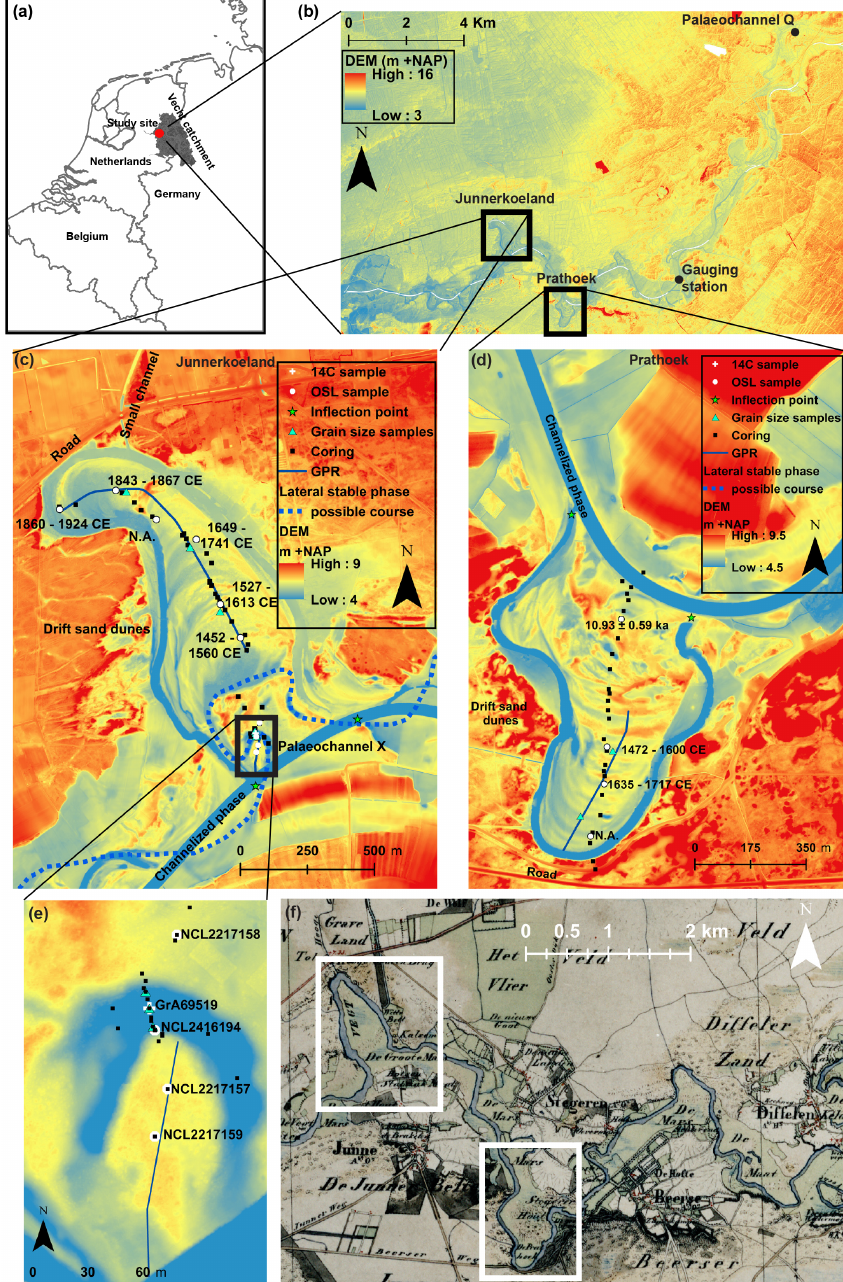
Figure 1. Maps of the Overijsselse Vecht. (a) Map showing the location of the Overijsselse Vecht catchment and the location of the study site. (b) Digital elevation map (DEM; Actueel Hoogtebestand Nederland, 0 . 5 × 0 . 5m) (Van Heerd and Van’t Zand, 1999) of the downstream section of the Overijsselse Vecht river, indicating both study sites: Junnerkoeland and Prathoek. DEM of the Junnerkoeland bend (c) and Prathoek bend (d) , including locations of cores, OSL samples by Quik and Wallinga (2018), the OSL and 14 C samples from this study, the GPR transects, the grain size samples, and inflection points. The possible historical course of Palaeochannel X according to Maas (1995) is indicated. (e) Zoomed-in figure of Palaeochannel X . (f) Topographical military map (TMK) dating from 1851CE (CC-BY Kadaster, 2018; Van der Linden, 1973), showing the Overijsselse Vecht during its meandering phase.